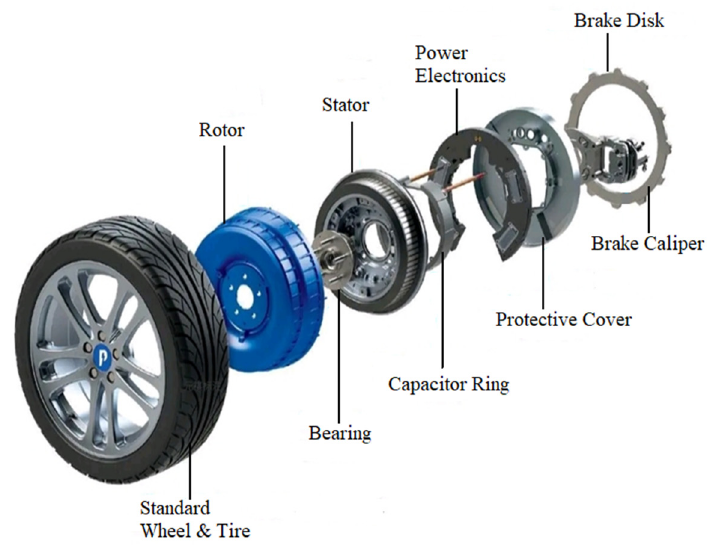
Figure 2. Structure diagram of in-wheel motor.